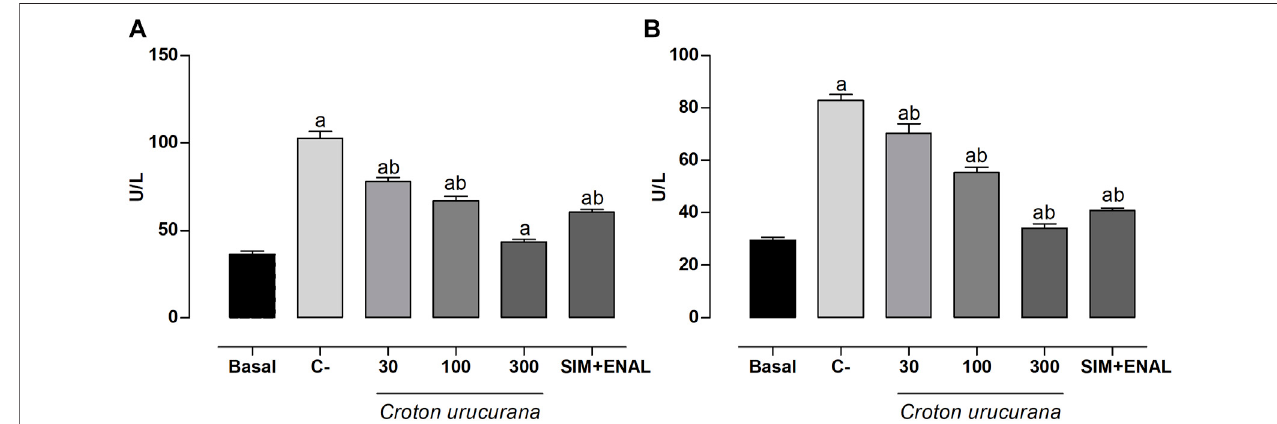
FIGURE 2 | Levels of markers of hepatic damage. (A,B) Plasma levels of aspartate aminotransferase (AST; U/L) (A) and alanine aminotransferase (ALT; U/L) (B) in normotensive,non-dyslipidemic,andnon-smokerrats(basalgroup)andhypertensive,dyslipidemic,andsmokerspontaneouslyhypertensiveratsthatweretreatedwith